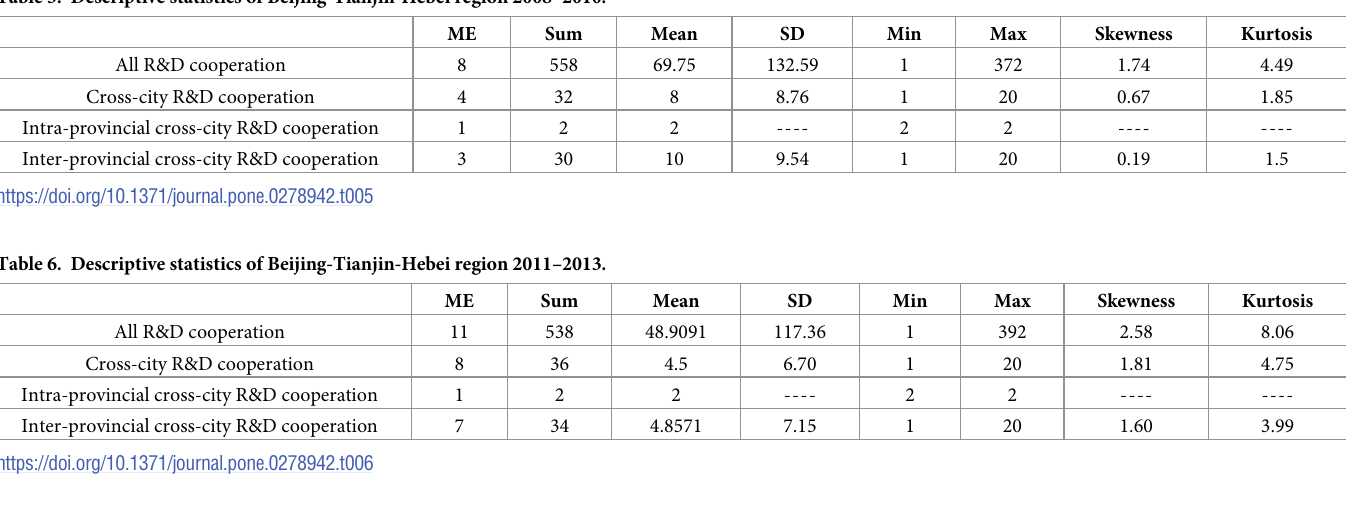
Table 5. Descriptive statistics of Beijing-Tianjin-Hebei region 2008–2010.